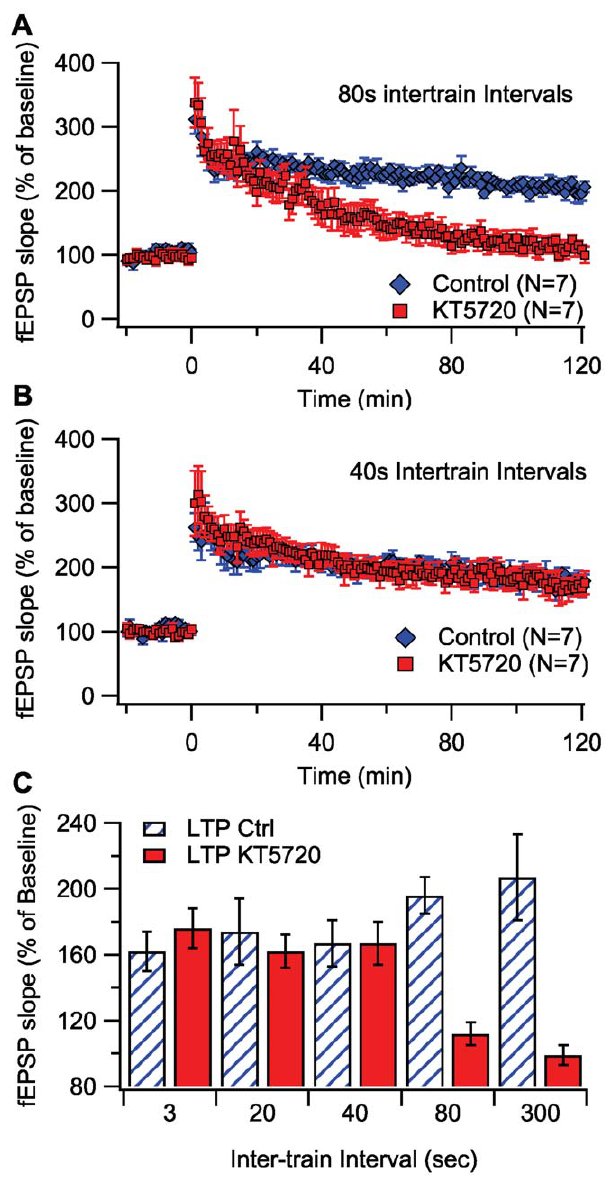
Figure 3. Experiments to verify that the critical inter-train interval for the PKA-dependence of L- LTP is , 60 sec. (A) LTP induced using a 80 sec inter-train interval (n=7) is blocked by KT5720 ( p , 0.05), which demonstrates PKA dependence. (B) In contrast, when using a 40 sec inter-train interval (bottom; n=7), LTP in KT5720 slices is not different from vehicle control ( p . 0.05), demonstrating PKA independence. In both panels, fEPSPs for KT5720 treated slices are shown with red circles, and vehicle controls with blue circles. (C) Summary of temporal sensitivity of PKA dependence of L-LTP. Data for 3 sec, 20 sec and 300 sec are from [3].